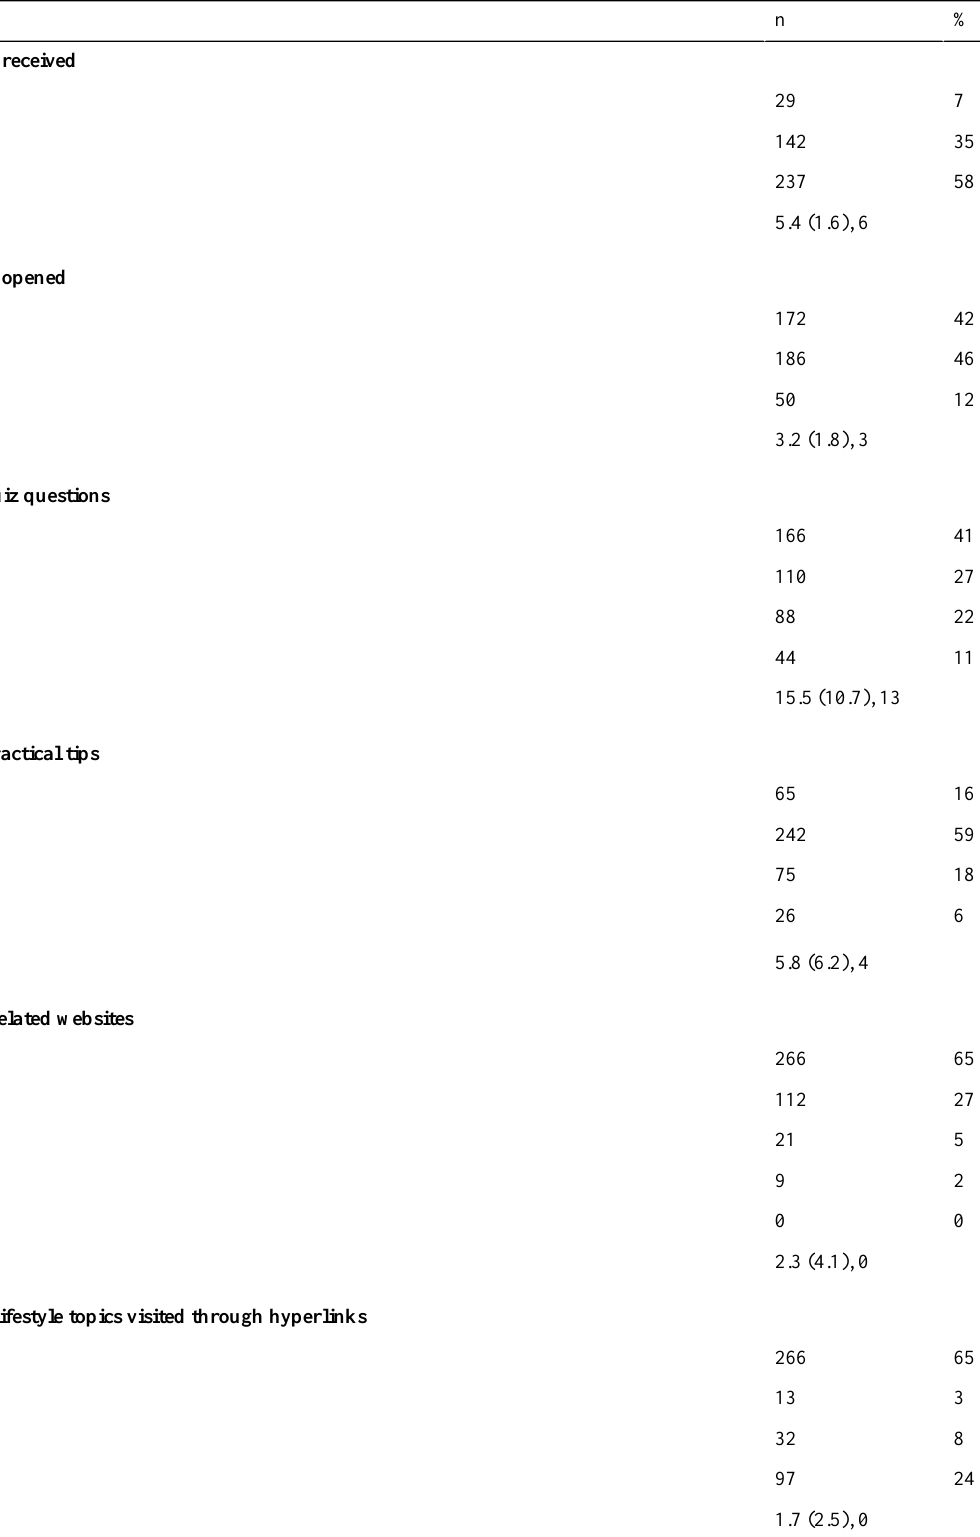
Table 3. Health-related information received and accessed by program users (n =